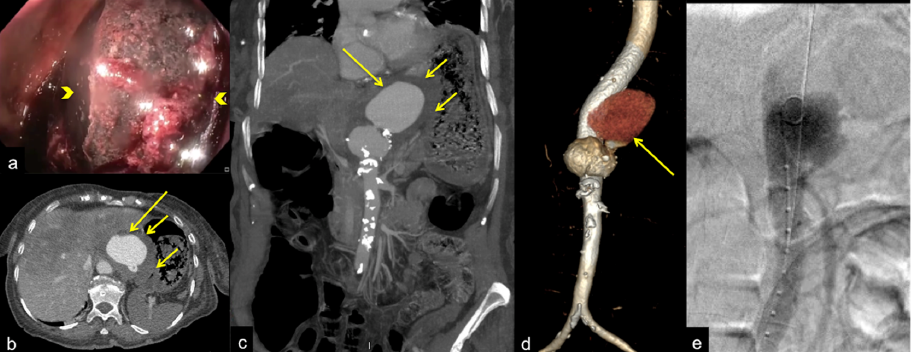
Figure 31. Abdominal pain and anaemia. Gastric endoscopy ( a ) shows an extrinsic bulging mass in the gastric corpus with a large adherent blood clot (( a ) arrowheads). Axial CTA artery phase ( b ) and coronal MIP artery phase reconstruction ( c ) show a contained rupture of a thoraco-abdominal aortic aneurysm (( b , c ) long arrows) with periaortic haematoma compressing the posterior gastric wall with loss of interface fat plane (( b , c ) short arrows). The VR-3D artery phase image recon- struction ( d ) better defines the extension of the aneurysm sac (( d ) long arrow) for endovascular operative planning. Angiography endovascular aneurysm repair procedure ( e ).